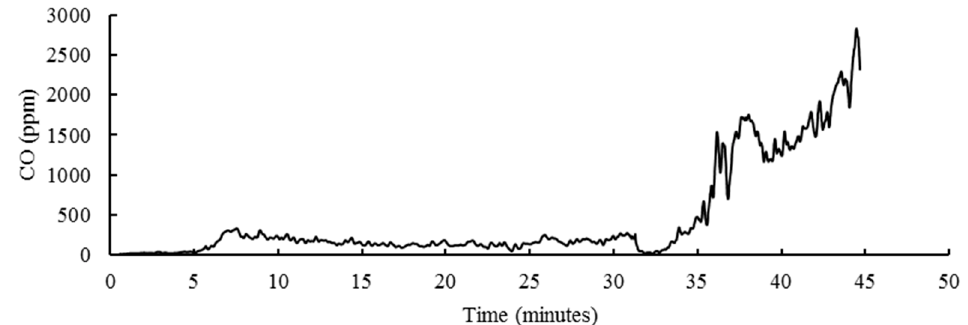
Figure 4. The typical CO emission of the Chinese burning cycle.